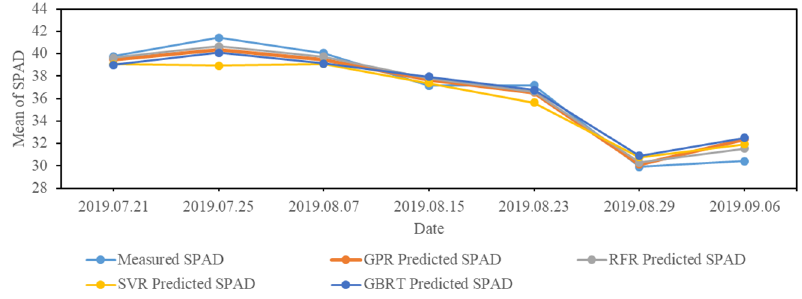
Figure 17. Dynamics of mean of SPAD value during July 21 to September 6, 2019.